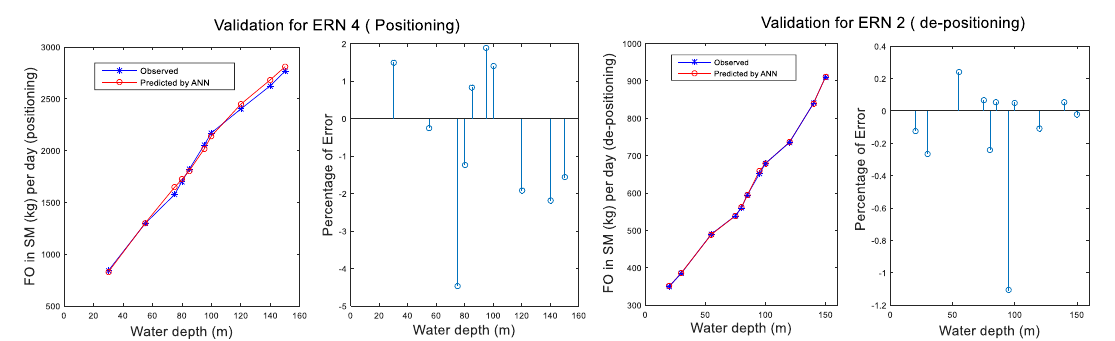
Figure 7. Comparison plot for observed and ANN predicted values (FO consumption for SM setup). The ANNs are then used to predict the FO consumption for the SM system in various depths for ERN 0. Figure 8 shows the predicted values for both positioning and de-positioning.